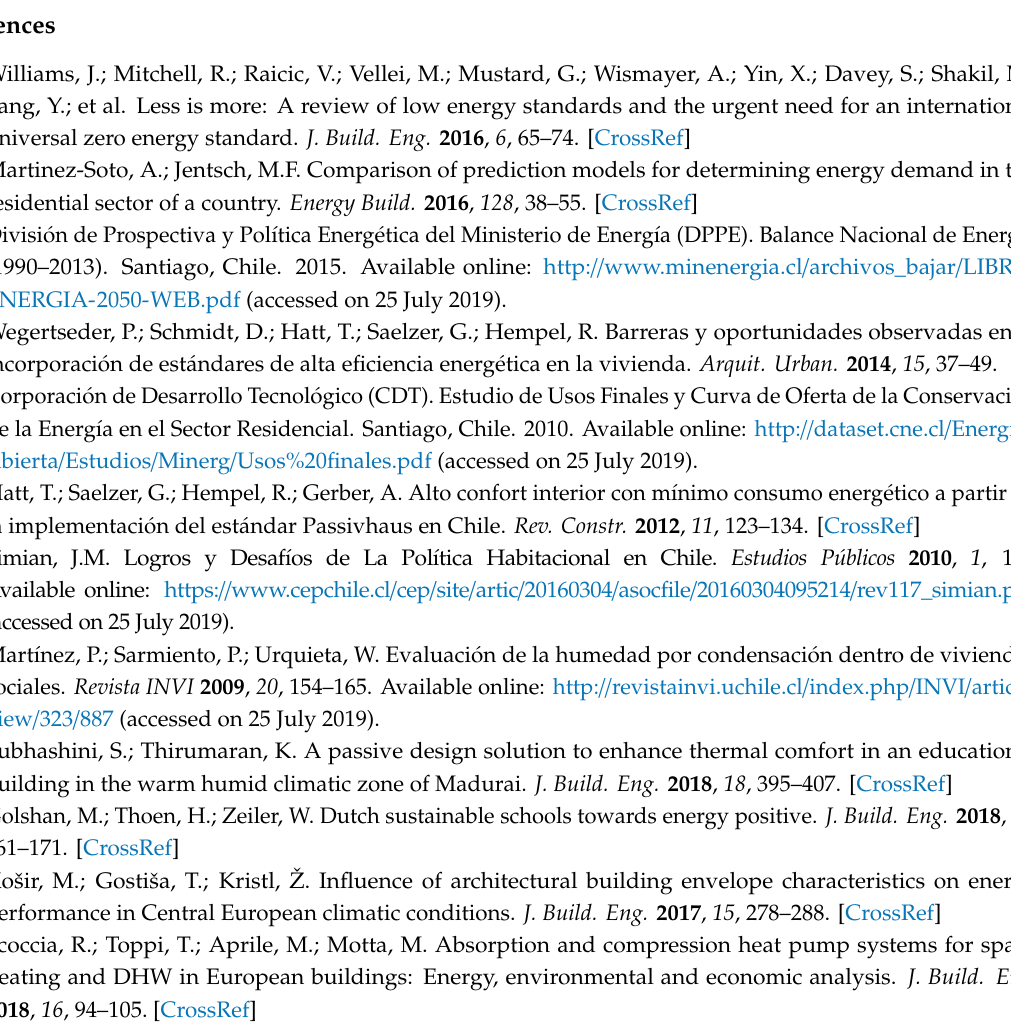
Figure A7. Primary Energy.